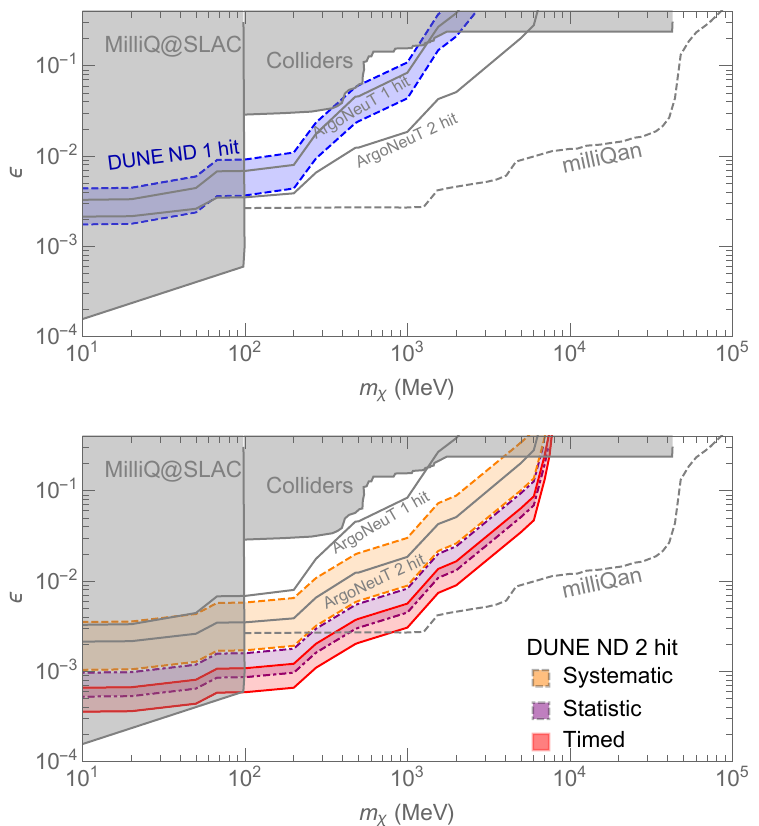
Figure 5 . The reach in the m χ - (cid:30) plane for millicharged particles for various analyses in the DUNE ND with our projection for 3 10 22 POT. For every analysis a band is shown which spans our × two benchmark assumptions for the backgrounds: scaling only with detector volume of scaling (low BG) also with beam intensity (high BG). Top: the sensitivity of a systematically limited single-hit analysis is shown in blue. Bottom: the sensitivity of double-hit analyses, requiring the two hits align with the target. A systematically limited search is shown in orange. A statistically limited search (making use of the angular distribution) is shown in purple. A statistically limited search with the occupancy reduced by light collection and timing is shown in red. Existing limits from other experiments, including SLAC MilliQ [16] and collider experiments [26–29], are shown in grey for both panels. The projections of 95% C.L. exclusion limit from the proposed milliQan experiment at the LHC with 3000 fb − 1 of integrated luminosity is shown in gray dashed curve [17].